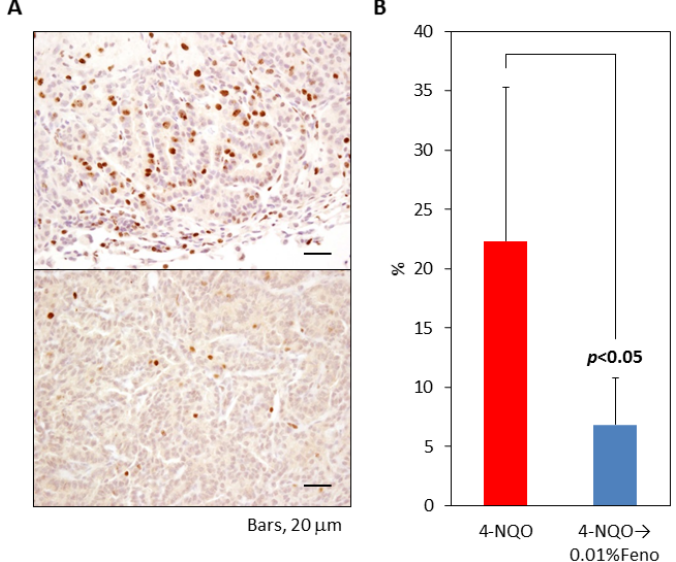
Figure 4. Ki-67 labeling index and immunohistochemistry of 4-NQO-induced pulmonary proliferative lesions from mice treated with or without fenofibrate. ( A ) Representative features of Ki-67 immunohistochemistry in a mouse treated with 4-NQO alone (upper; group 1) or 4-NQO followed by 0.01% fenofibrate (lower; group 2). Bars = 20 μ m; ( B ) Dietary administration of 0.01% fenofibrate significantly lowered the Ki-67 labeling